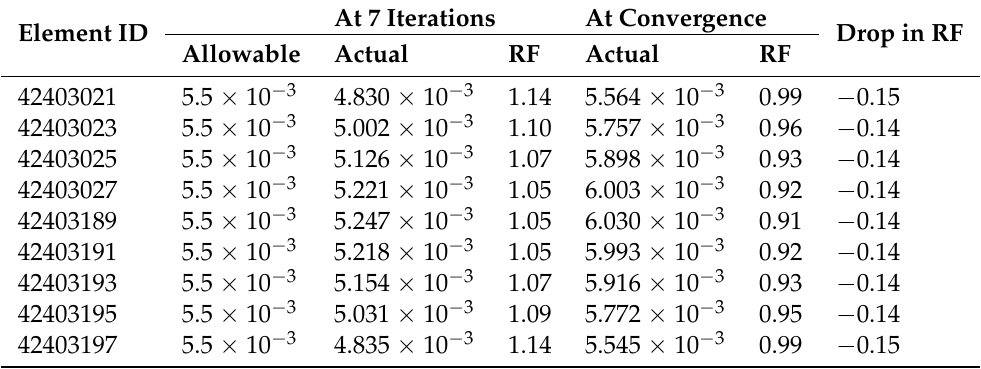
Table 2. Composite axial